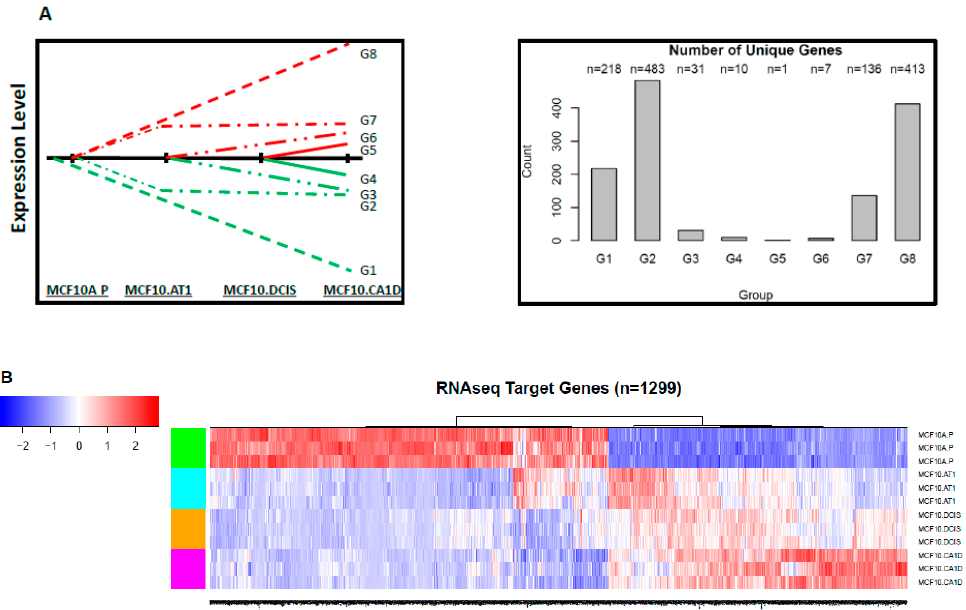
Figure 6. Target genes that changed significantly during breast cancer progression. ( A ) Schematic showing the eight patterns of interest and the number of target genes that mapped to each of these groups. ( B ) Heat map showing the expression pattern of target genes that significantly changed and thus depict global mRNA changes across the spectrum of breast cancer progression. The color key shows blue as the lowest expression and red as the highest expression.